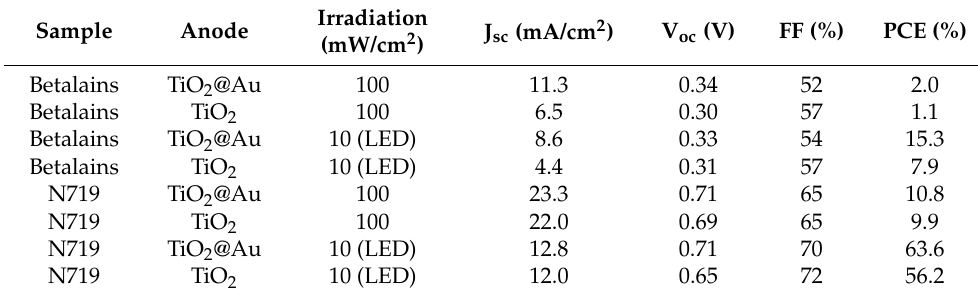
Table 3. Electrical parameter at 1 SUN, 100 mW/cm 2 (solar simulator) and 0.1 SUN, 10 mW/cm 2 (LED).